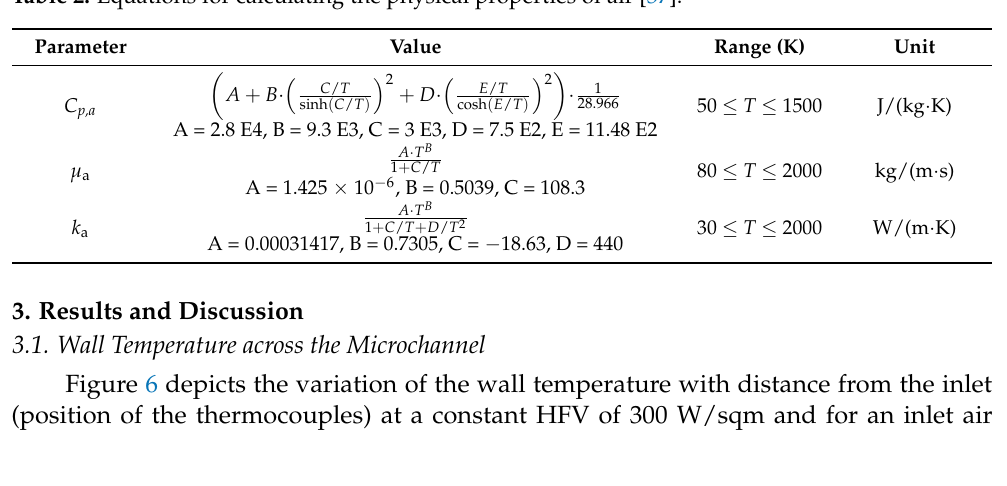
Table 2. Equations for calculating the physical properties of air